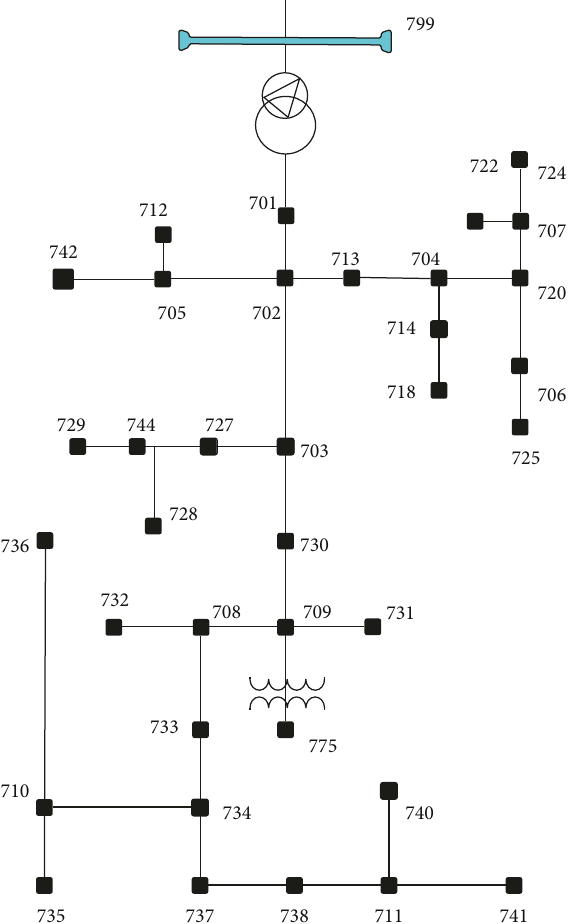
Figure 6: Topological diagram of the IEEE37 node power distri- bution system after transformation.